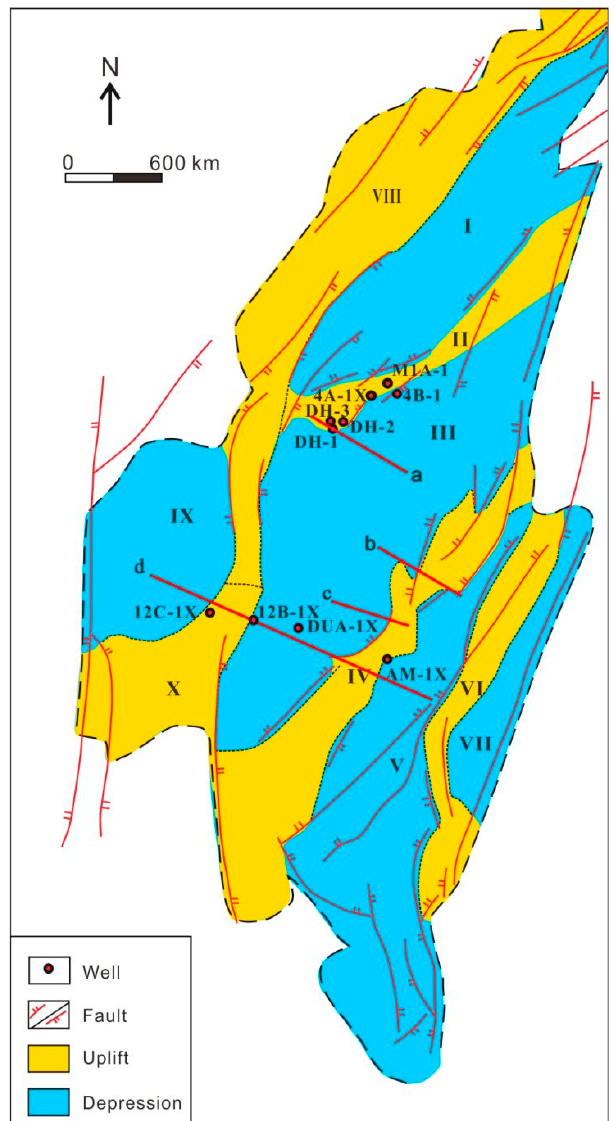
Figure 2. Schematic tectonic map of Wan’an Basin. The thick red lines represent the locations of seismic tracks [9,23]. Ⅰ Northern depression; Ⅱ Northern uplift; Ⅲ Central depression; Ⅳ Central uplift; Ⅴ Southern depression; Ⅵ Eastern uplift; Ⅶ Eastern depression; Ⅷ Northwest fault zone; Ⅸ Western depression; Ⅹ Southwest slope.